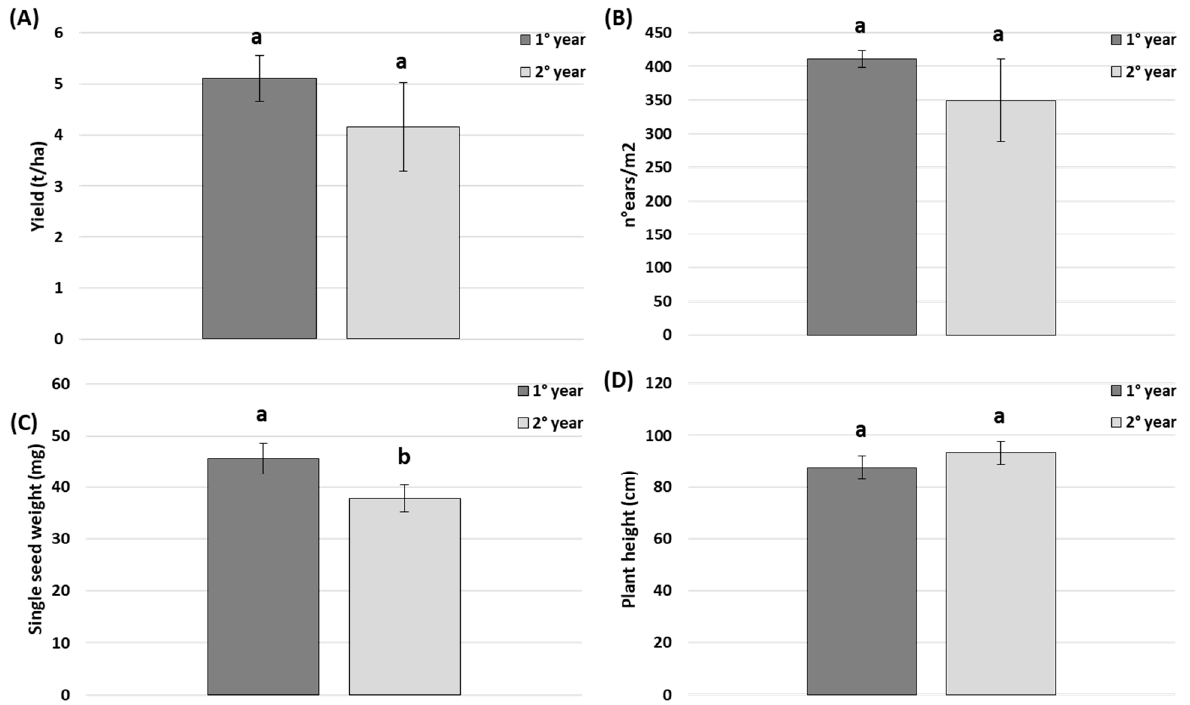
Figure 2. The measured yield ( A ), n°ears/m 2 ( B ), single-seed weight ( C ) and plant height ( D ) of San Pastore wheat in Valleggia. For each parameter measured, different letters indicate statistically significant differences ( t -test, p < 0.05).